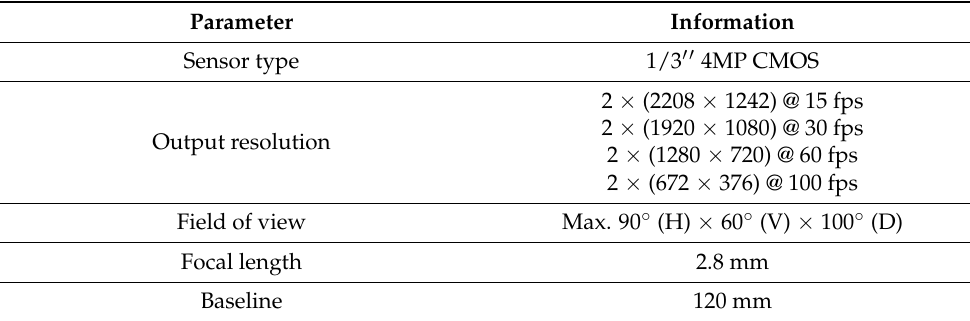
Table 4. Technical specifications of the ZED stereo camera.